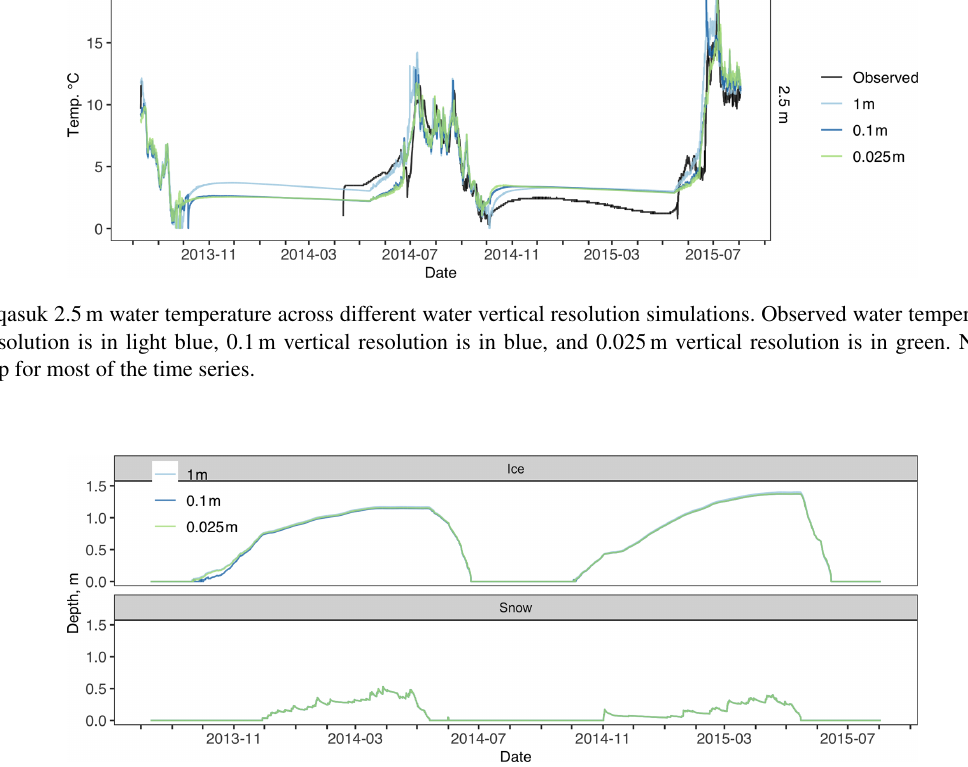
Figure D3. Atqasuk ice and snow depth across different water vertical resolution simulations. No observed data are available, 1m vertical resolution is in light blue, 0.1m vertical resolution is in blue, and 0.025m vertical resolution is in green. Note that data overlap for most of the time series.